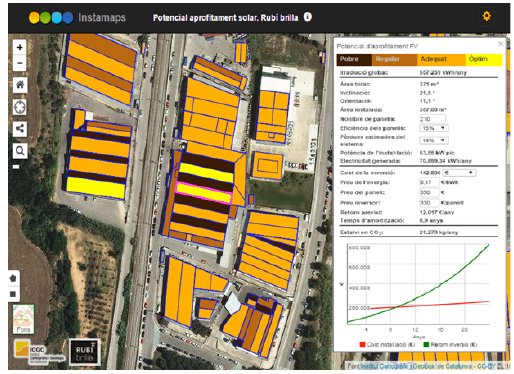
Figure 6 Application to provide the solar potential of buildings based on LiDAR data